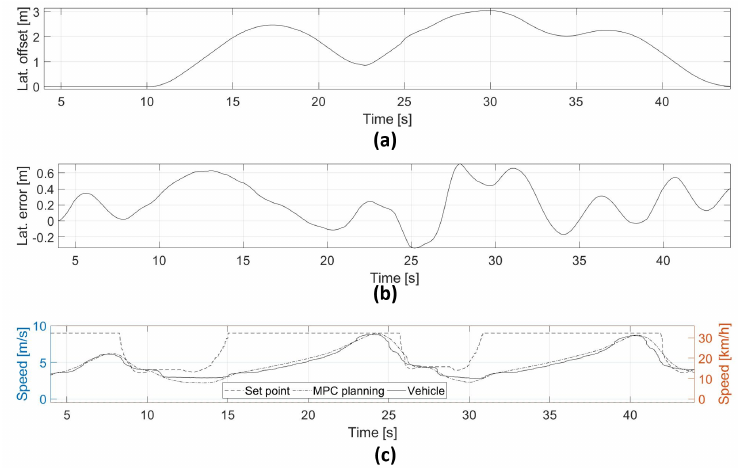
Figure 9. ( a ) Lateral offset used for the obstacle avoidance maneuvers, ( b ) lateral error with respect to the generated trajectory, ( c ) vehicle speed depending the test track